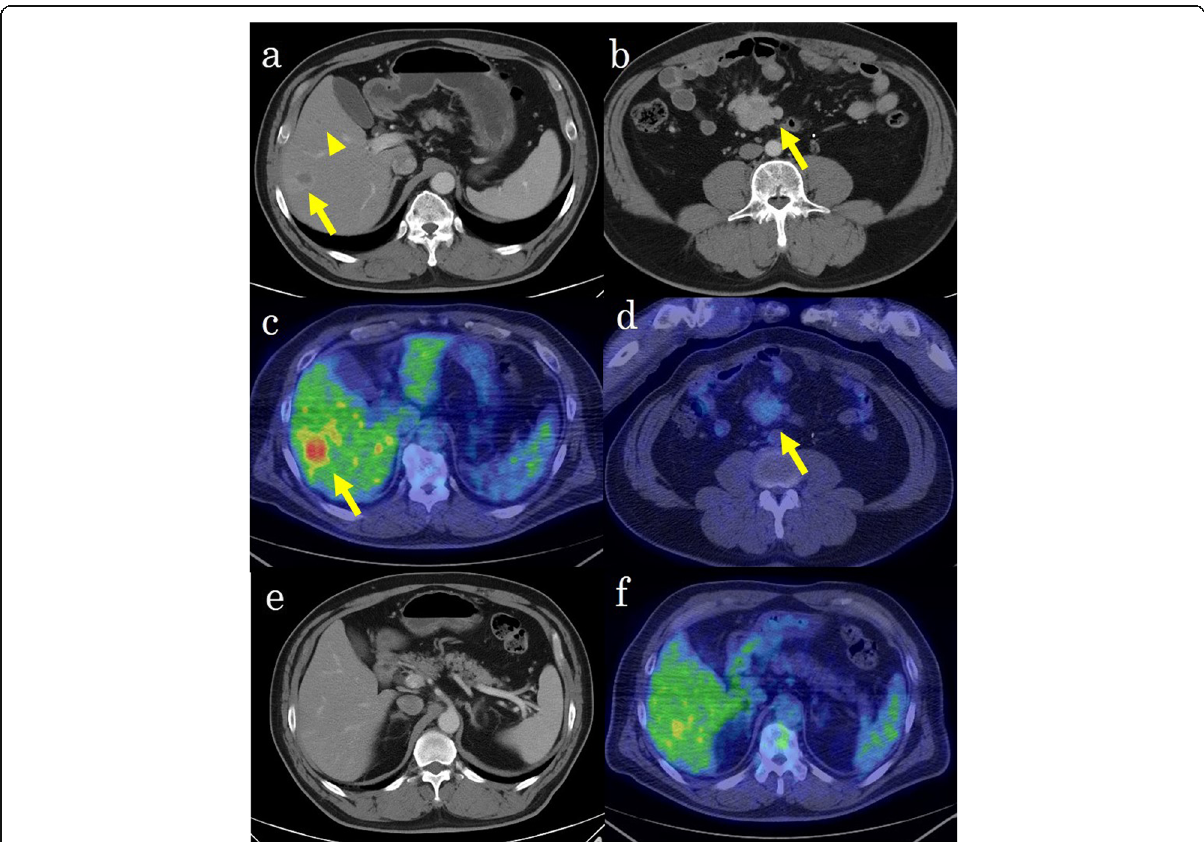
Fig. 1 Contrast-enhanced computed tomography (CT) and [18F]-fluorodeoxyglucose positron emission tomography (FDG-PET) images 1 year after abdominoperineal resection. a Contrast-enhanced CT showed two tumors in segment 5 (arrow and arrowhead) that were enhanced in the arterial phase. b Contrast-enhanced CT showed a 47-mm tumor in the ileal mesentery (arrow) that was enhanced in the arterial phase. c On FDG- PET, accumulation of [18F]-FDG was found in segment 5 (arrow) tumor. d On FDG-PET, only a little accumulation of [18F]-FDG was found in the ileal mesenteric tumor (arrow). e Contrast-enhanced CT showed no tumor in segment 6 that was enhanced in the arterial phase. f On FDG-PET, no accumulation of [18F]-FDG was found in segment